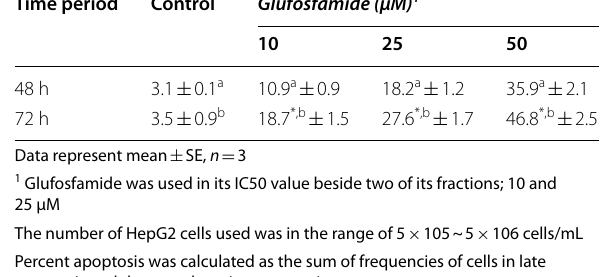
exhibited higher apoptosis frequencies than those HepG2